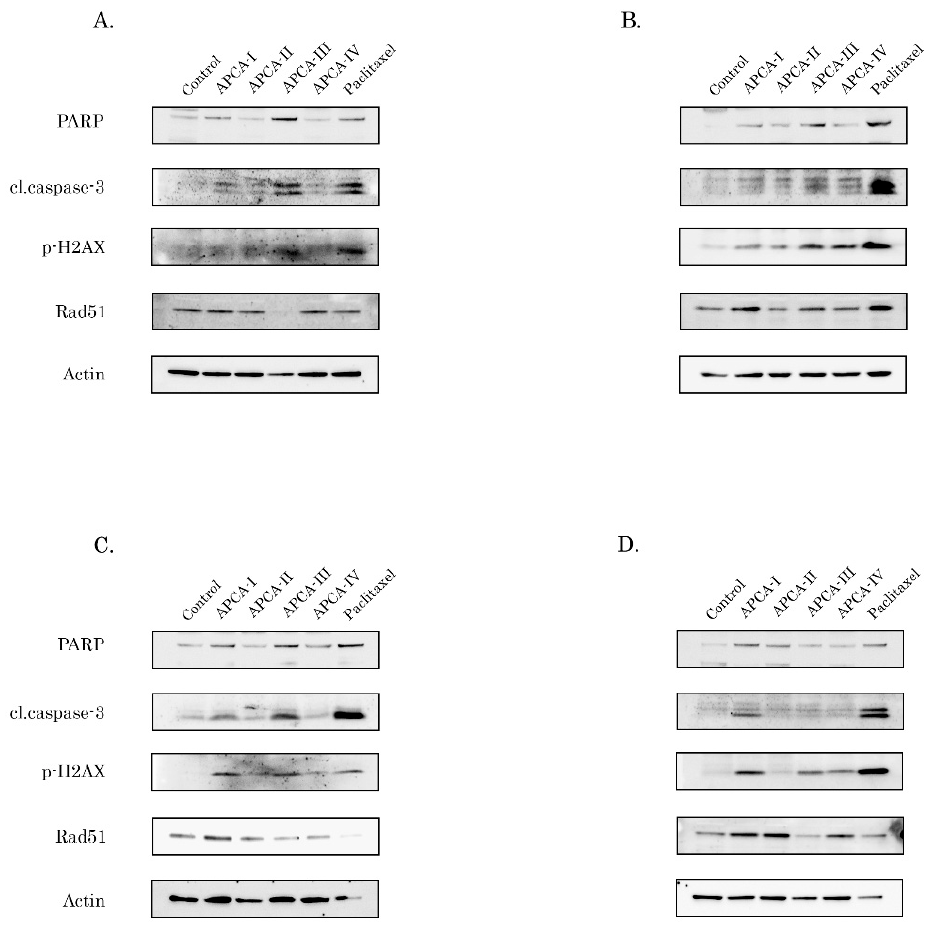
Figure 6. The 2-APCAs induce apoptosis of osteosarcoma (OS) and soft tissue sarcoma (STS) cell lines. Immunoblot analysis for apoptosis markers (cleaved forms of PARP and caspase-3), Rad51 recombinase, and γ -H2AX in U2-OS ( A ), SAOS-2 ( B ), A673 Ewing’s sarcoma ( C ), HT-1080 fibrosarcoma ( D ) cells after treatment with DMSO (negative control), 2-APCAs (I-IV), and paclitaxel for 72 h. Actin stain used as a loading control.